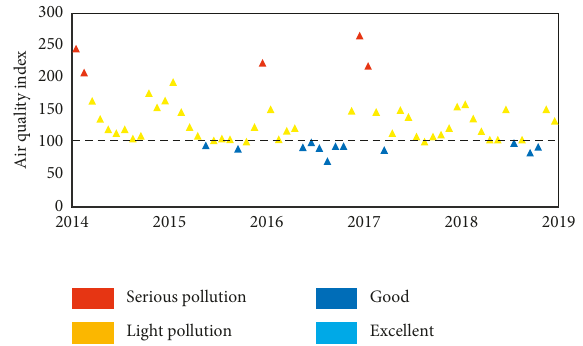
Figure 3: Air quality index (AQI) in Handan from 2014 to